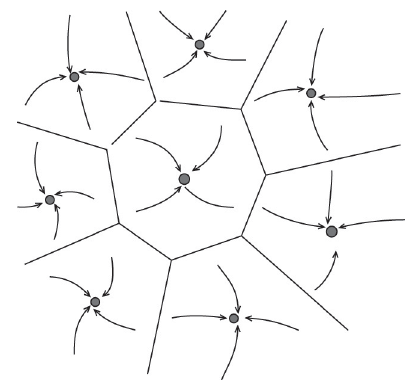
Figure 2 | Schematic depiction of the space of states of an attractor network. Stable states are shown as fi lled circles. The represented network has one background state (shown schematically as a grey circle in the center) and several mem- ory states (black circles). Arrows represents the dynamics of the network towards an attractor, following presentation of a stimulus. Lines represents the limits of the basin of attraction of each attractor. From Brunel